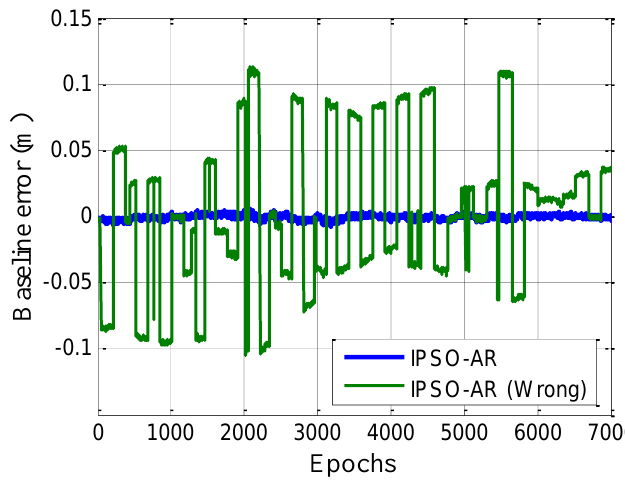
Figure 13. Baseline length errors after single-epoch real-time kinematic (RTK) process with IPSO–AR method.